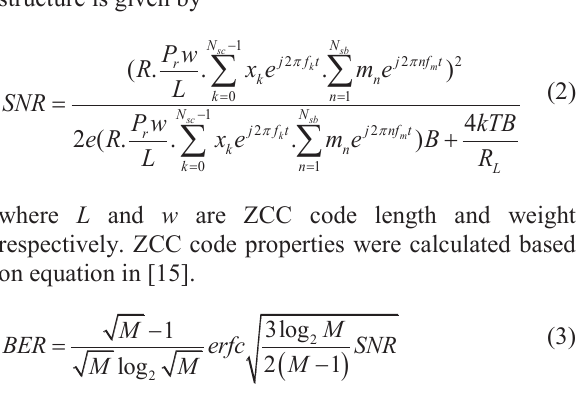
Fig. 2 Catenated-OFDM Optical CDMA based on ZCC architecture